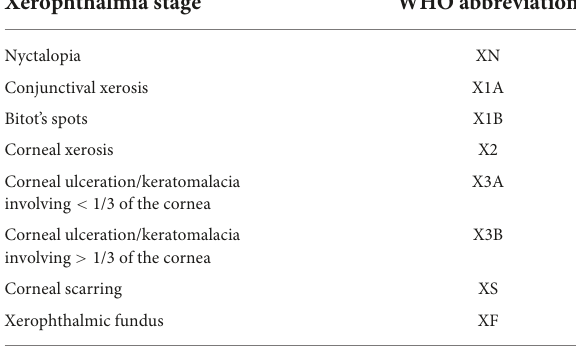
TABLE 2 World Health Organisation classification of xerophthalmia, based on clinical ophthalmological features. Shaded cells correspond to retinal